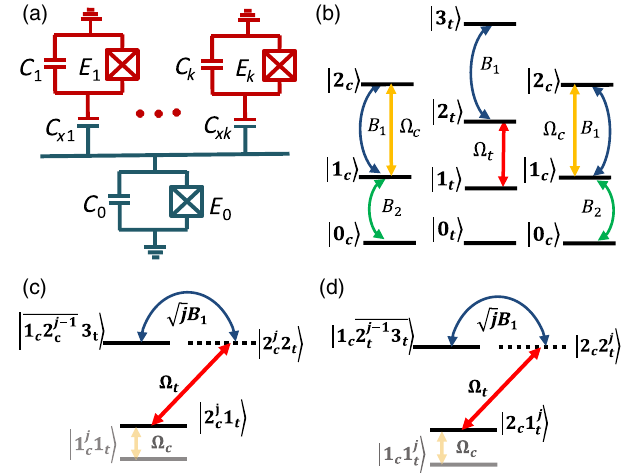
FIG. 5. Implementation of adiabatic multiqubit gates with superconducting circuits. (a) The k -control (target) qubits and a single-target (control) qubit applied in the multiqubit Toffoli (fan-out) gate. (b) Level structure of two control and one target qubit systems for the Toffoli gate, showing the resonant exchange processes with strengths B 1 and B 2 . (c) [(d)] Coupling of levels leading to multiqubit dark superposition states (10) in the Toffoli (fan-out) gates where only the state components shown in bold face are populated. The overline symbols in the state kets are explained in the